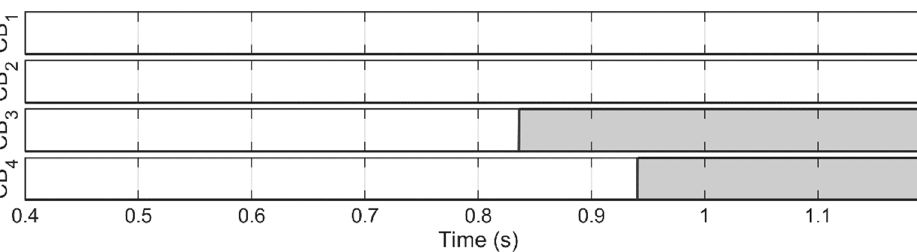
Figure 18. Operation of circuit breakers in case DCR fails.